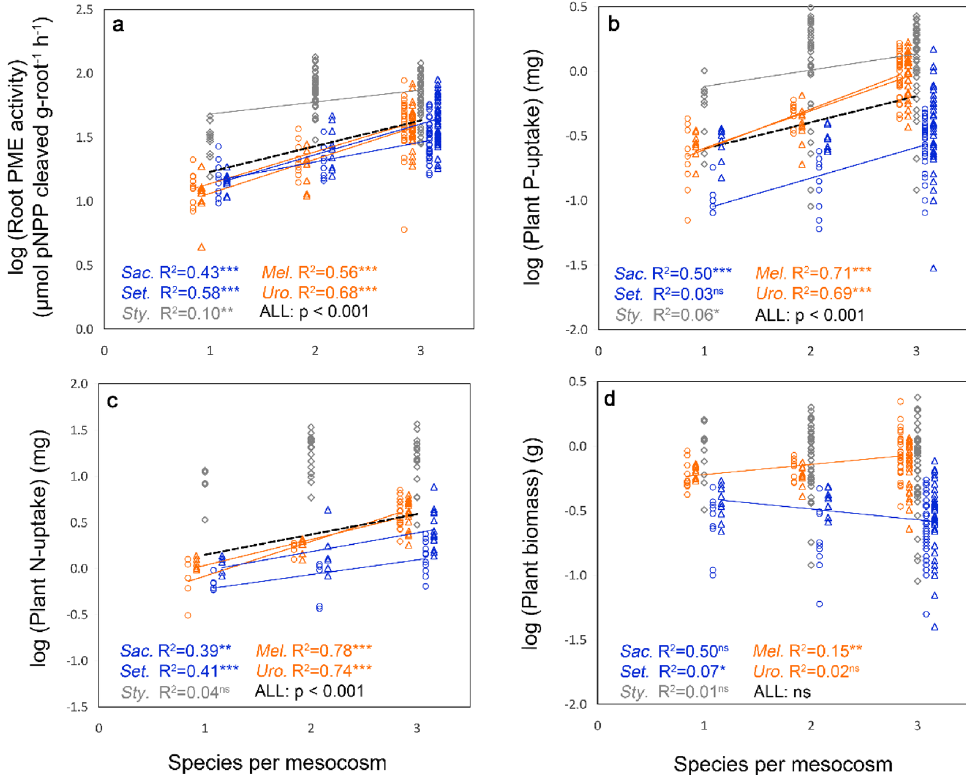
Figure 3. Effects of species richness on root phosphatase (PME) activity, P and N uptake and biomass production of native and alien Cerrado plants in a mesocosm experiment. ( a ) Root phosphatase (PME) activity, ( b ) and ( c ) total P and N uptake from the soil (mg P in 49 days) and ( d ) plant biomass (shoot + root) at harvest (t = 7 weeks) of two alien grasses ( Melinis minutiflora— orange circles ) and Urochloa decumbens— orange triangles), two native Cerrado grasses ( Saccharum asperum— blue circles and Setaria poiretiana— blue triangles ) and a native leguminous forb ( Stylosanthes guianensis— grey losanges) growing in monocultures or in mixtures of two or three species. P fertilization did not have a significant effect on these variables (Suppl. Table 2), therefore the two P treatments were pooled in the regressions. Orange, blue and grey regression lines show significant regressions per species. The dashed black line (ALL) shows the overall effect of the number of species on root PME activity, P and N uptake performed with species identity as random factor (nlme). The design of the experiment is shown in Suppl. Figure 1. Additional statistics are in Suppl. Table 2. To improve visibility of the results in the graphs we subtracted 0.1 or 0.2 from ‘species per mesocosm’ for the alien grasses and added 0.1 and 0.2 for the native